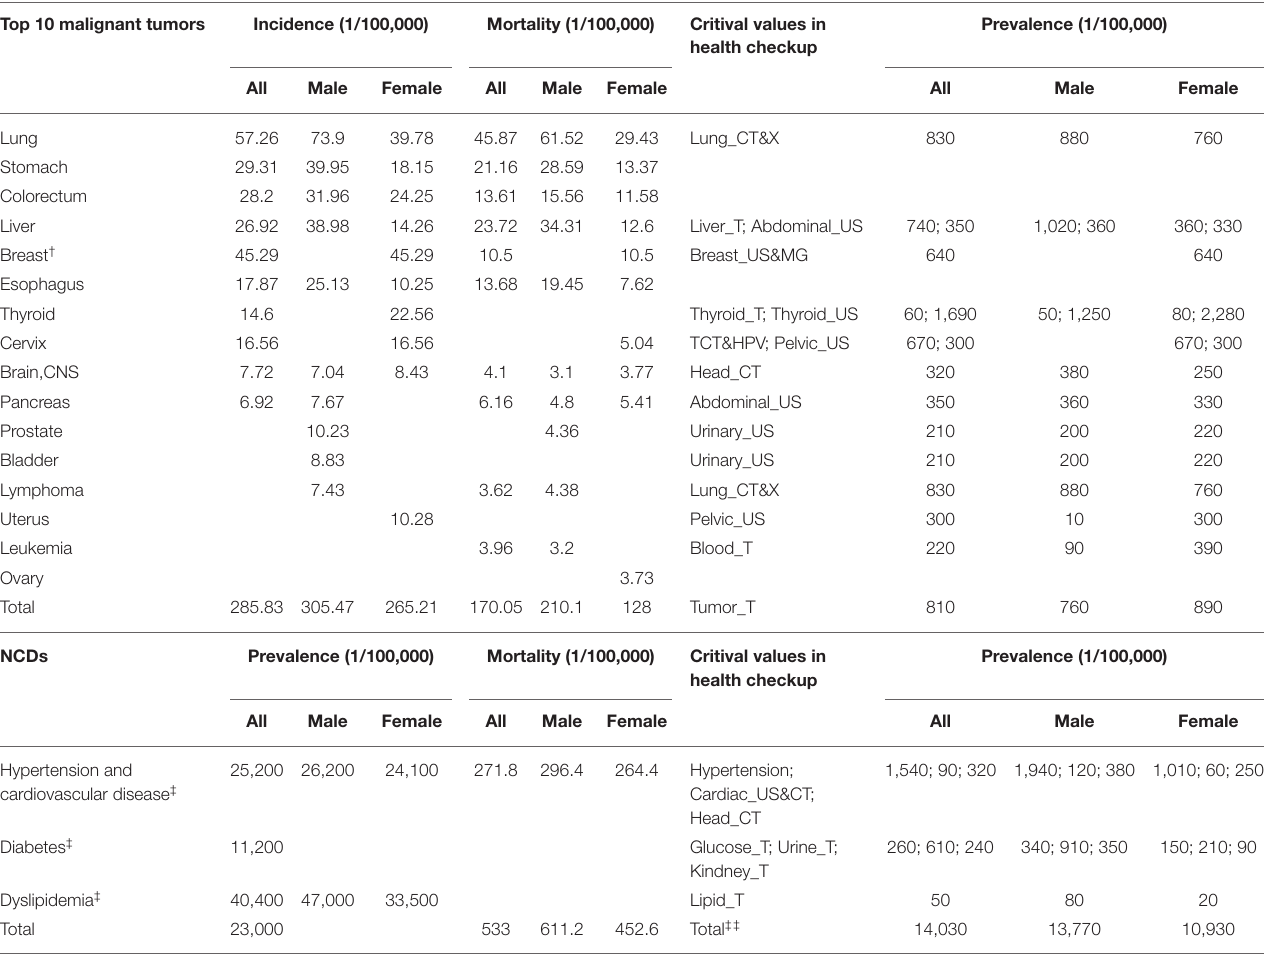
TABLE 8 | The incidence and the mortality of malignant tumors and NCDs with partial critical values. Top 10 malignant tumors Incidence (1/100,000) Mortality (1/100,000) Critival values in